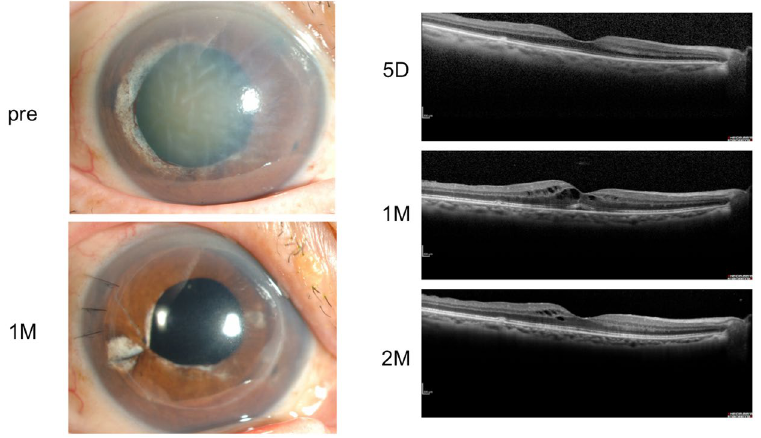
Figure 2. Representative case. The right eye of a 71-year-old female who had undergone argon-laser iridectomy for primary angle-closure glaucoma (PACG) in 2007. Since that time, corneal endothelial dysfunction had gradually progressing, resulting in bullous keratopathy (BK) and a visual acuity (VA) of 20/2000. Thus, she was treated by Descemet’s stripping automated endothelial keratoplasty combined with cataract surgery in July 2013. Her dilated pupil was reconstructed by iris suture. Postoperative inflammation was not severe, and the findings of an optical coherence tomography (OCT) examination at 5-days postoperative were normal, although the OCT image was not clear due to severe BK and cataract prior to surgery. At her 1-month follow-up visit, cystoid macular edema (CME) was observed and a 2-times daily administration of bromfenac eye drops was added to the routine postoperative treatment. The following month, the CME decreased and her VA was 20/20.